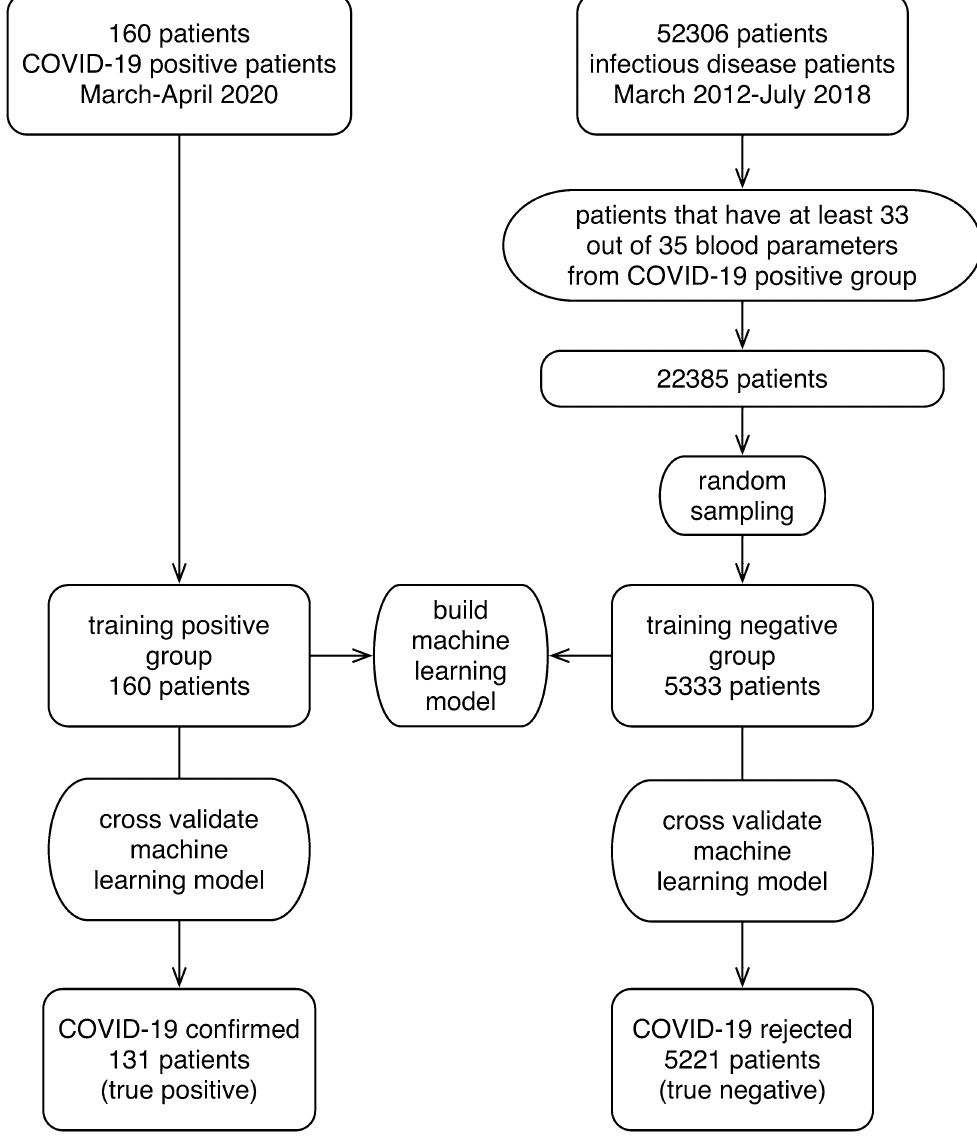
Figure 1. A flow chart of patients included in the model building and validation